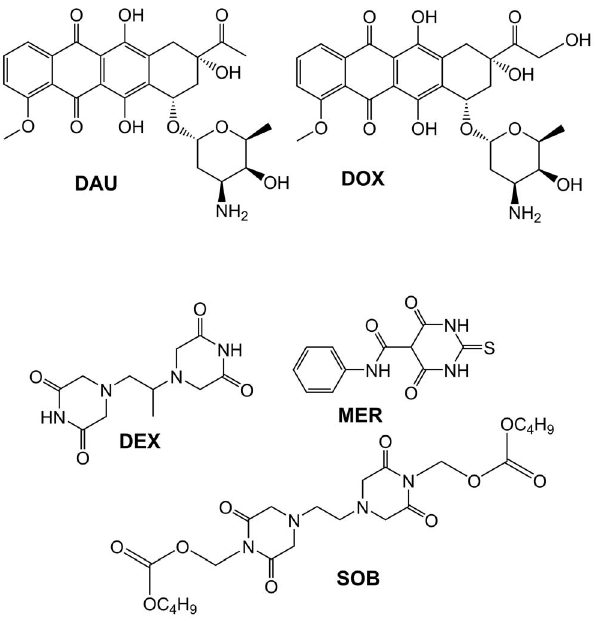
Figure 1. Chemical structures of the anthracyclines and the topoisomerase II catalytic inhibitors used in this study. Anthracyclines doxorubicin (DOX) and daunorubicin (DAU) and topoisomerase II catalytic inhibitors dexrazoxane (DEX), sobuzoxane (SOB) and merbarone (MER) were used in this study.